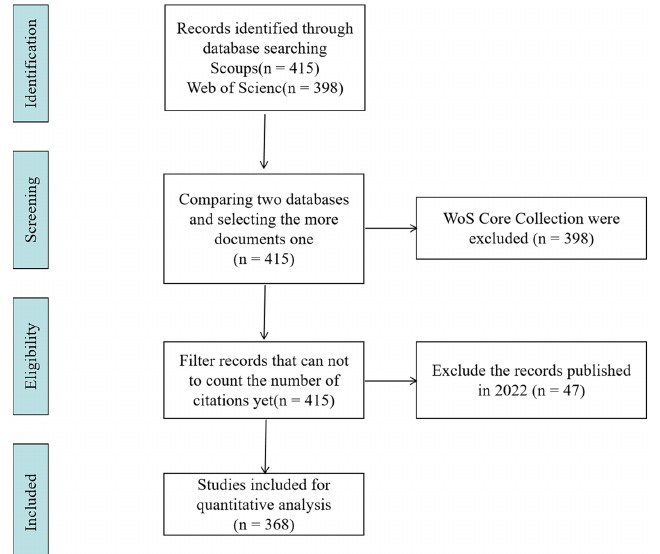
Figure 1. Flow diagram of study selection procedure.